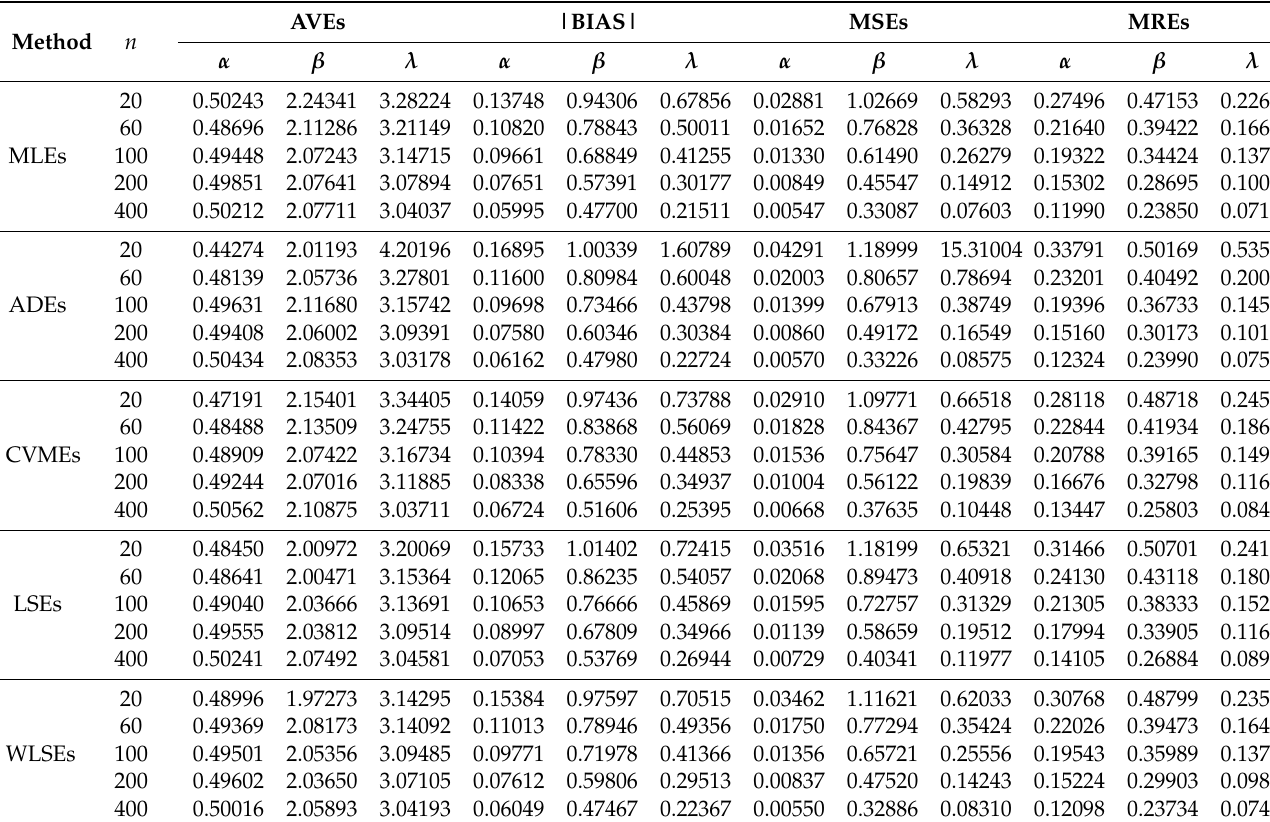
Table 6. Numerical values of the Ex-LL distribution for the parameters α = 0.5, β = 2, λ =